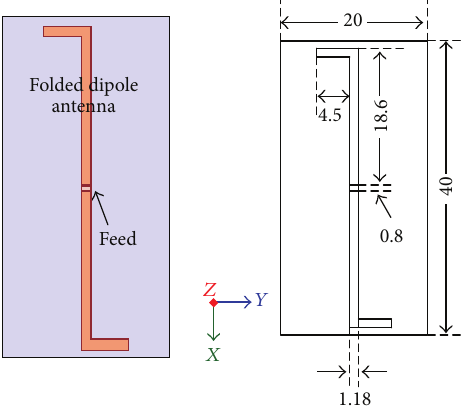
Figure 1: Configuration and dimensions of the proposed printed dipole antenna (unit: mm).